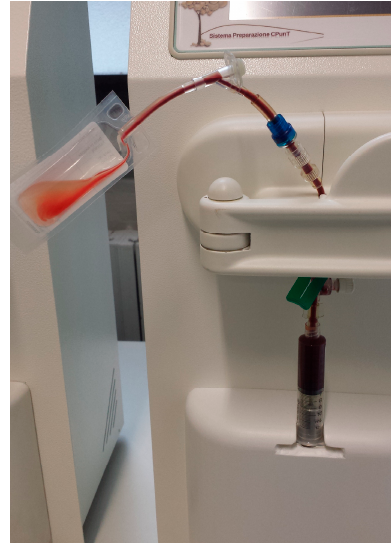
Figure 4. The supernatant plasma, the buffy coat and the surface of the erythrocytes layer pulled into the storage bag during the separation.